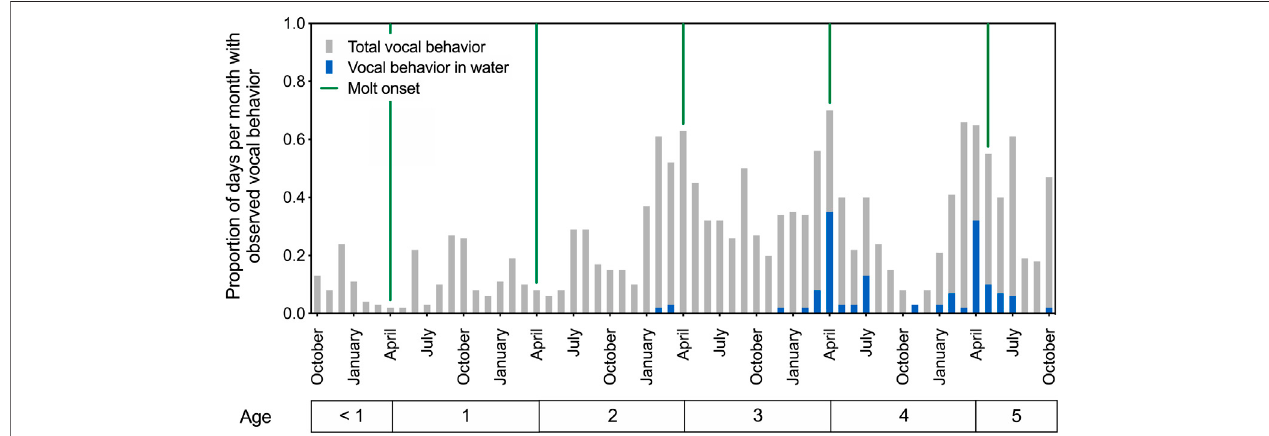
FIGURE 1 | Patterns of call production for two developing male spotted seals from ages 6 months to 5 years. The proportion of days per month with observed vocal behavior is plotted over time, with each bar representing a 1-month period and providing averaged data for the two seals. Green vertical lines indicate the onset of annualmoltandpresumedendofthebreedingseason.Totalvocalbehavior(inairorwater)increasedasthesealsaged,andunderwatervocalproductionemergedwith presumed sexual maturity around age 4. Peak underwater calling activity was observed in April at ages 4 and 5.